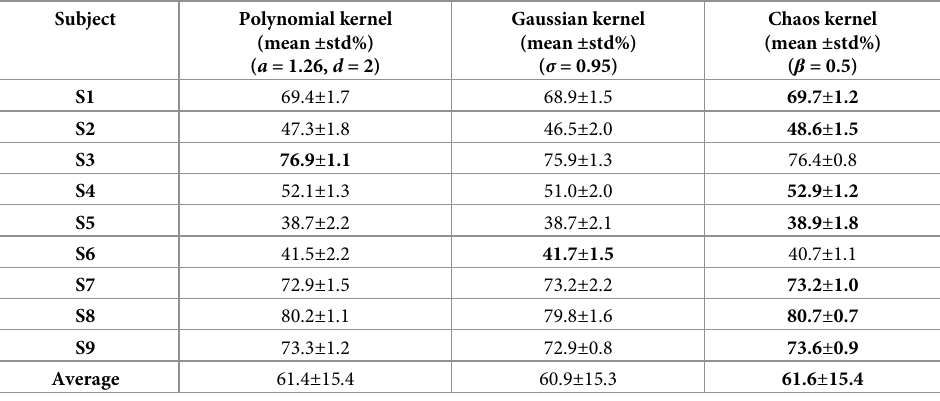
Table 1. Comparison of 3-kind kernels based on RVM on session T.